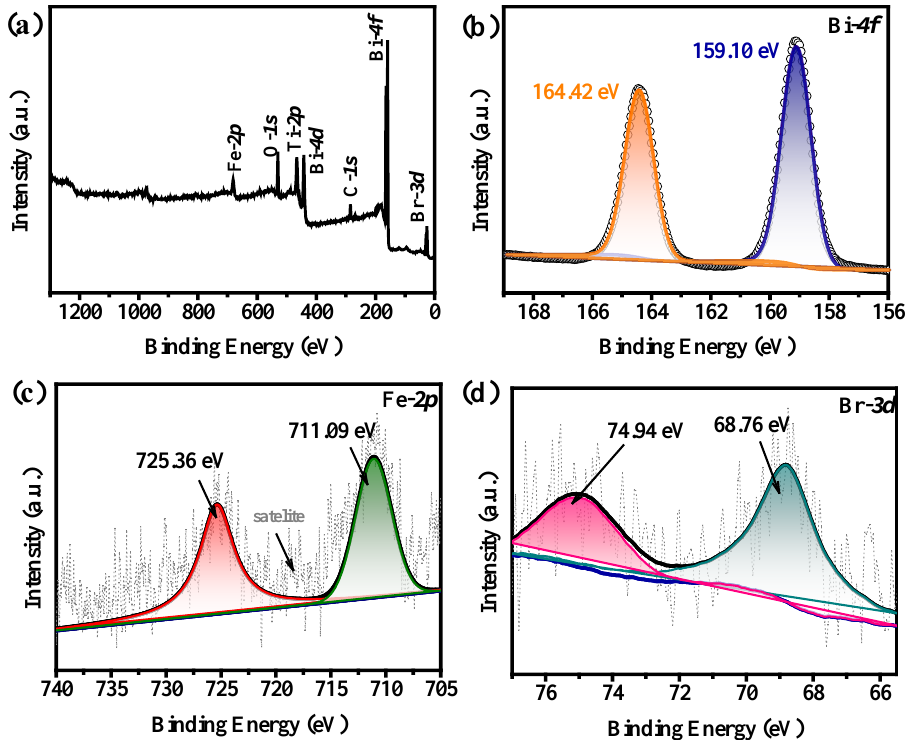
Figure 3. ( a ) XPS survey spectra of BFTOB corresponding to Bi, Fe, Ti, O and Br. High resolution XPS spectra of ( b ) Bi 4 f , ( c ) Fe 2 p , and ( d ) Br 3 d of BFTOB, respectively.